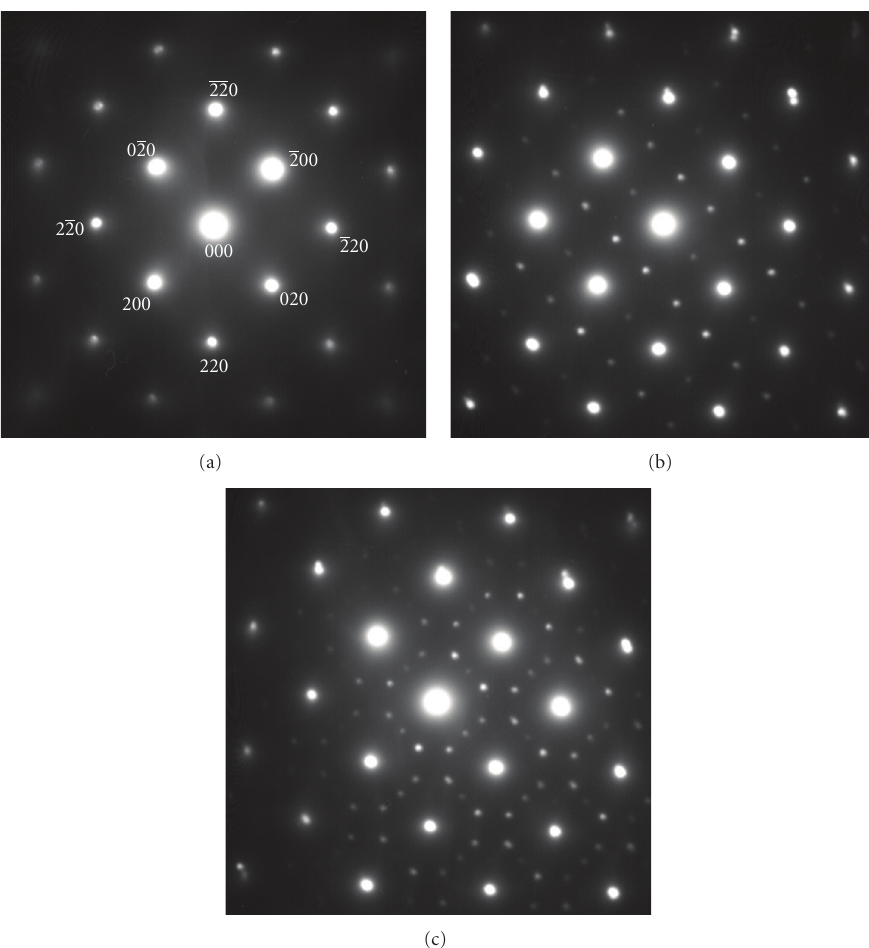
Figure 8: Experimental SAD patterns of the matrix (a) and of the precipitate seen Figure 6 in locations 1 (b) and 2 (c). The patterns were identified as the [001] γ zone axis for the matrix (a), the [100] γ (cid:3)(cid:3) for location 1, and the [100] γ (cid:3)(cid:3) and [010] γ (cid:3)(cid:3) for location 2.